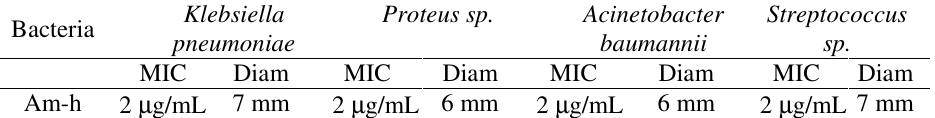
Table 2. Evaluation of the minimum inhibitory concentration (MIC) and the inhibition zone diameter of (Am-h) compound against the bacteria ( Klebsiella pneumoniae , Proteus sp. , Acinetobacter baumannii , Streptococcus sp.